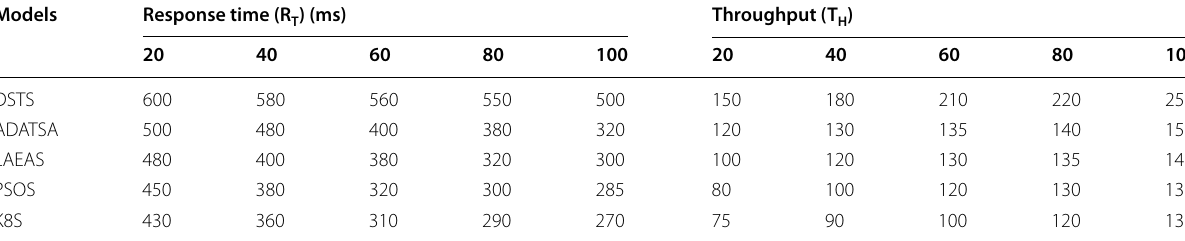
Table 4 Comparative analysis of quality of service metrics